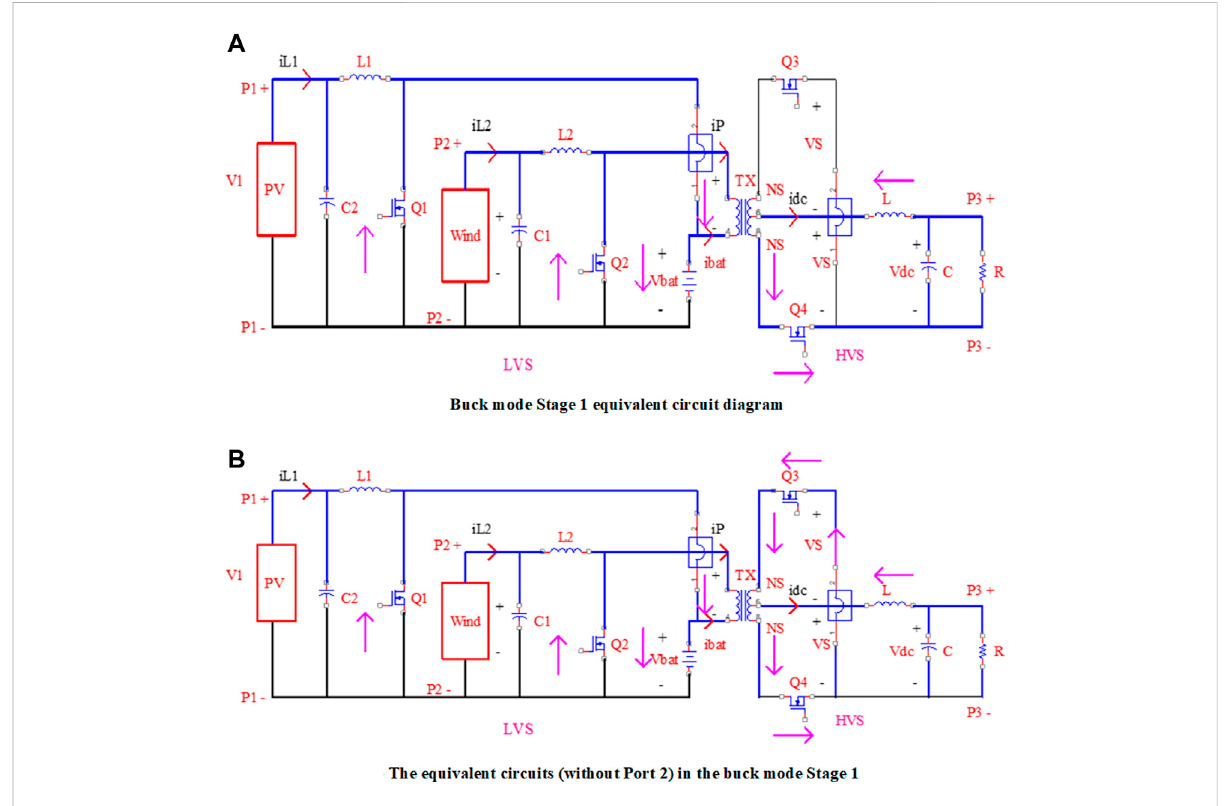
FIGURE 6 The proposed converter ’ s study in boost mode without